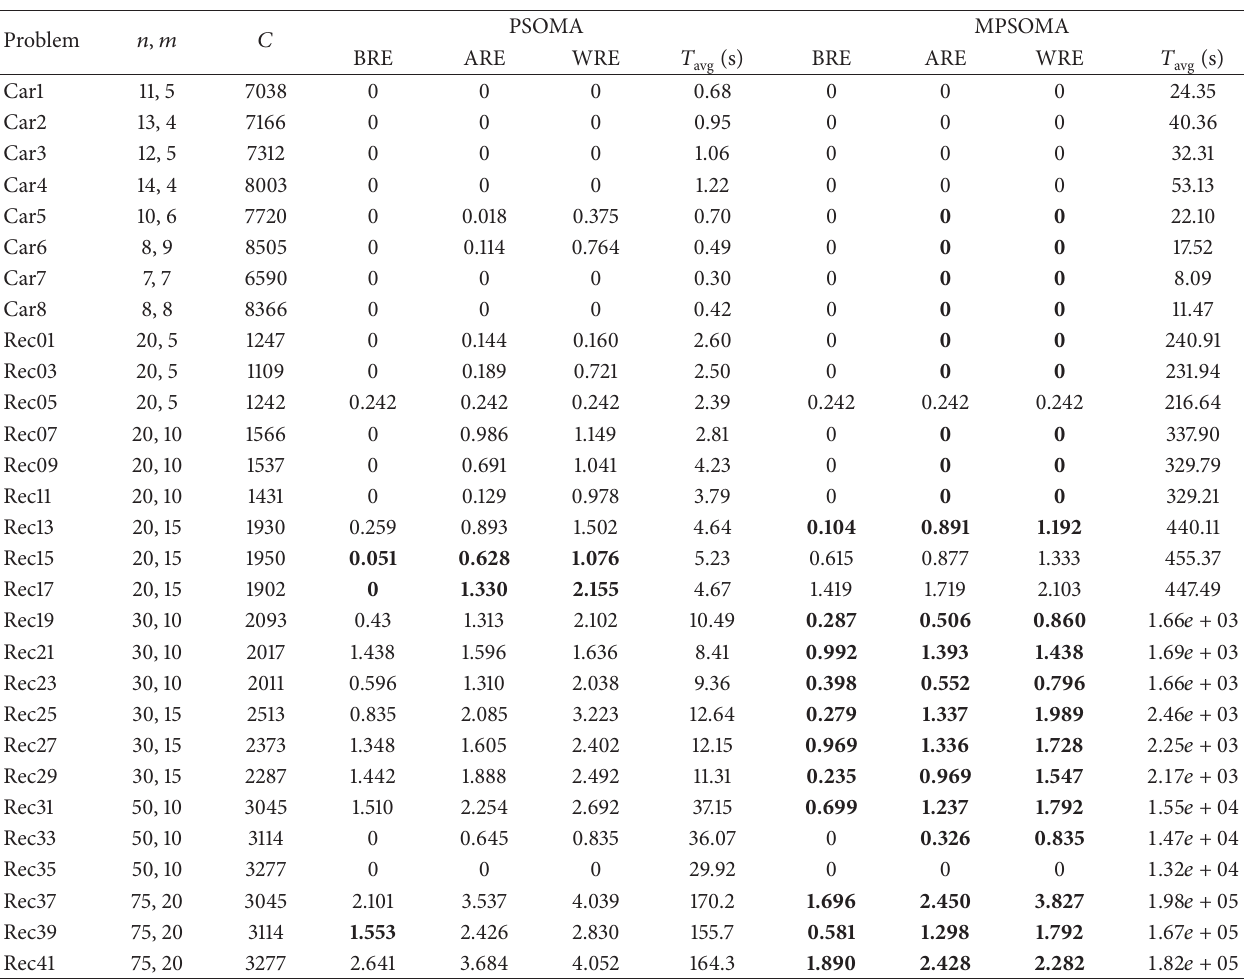
Table 2: Comparisons of PSOMA and